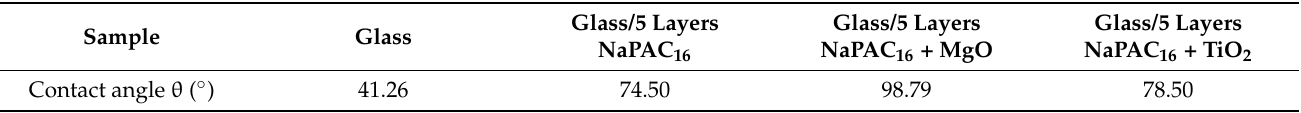
Table 6. Static contact angle values measured on the glass slide substrate. Dip-coated glass slides (five-layer coatings)— contact angle θ ( ◦ ).